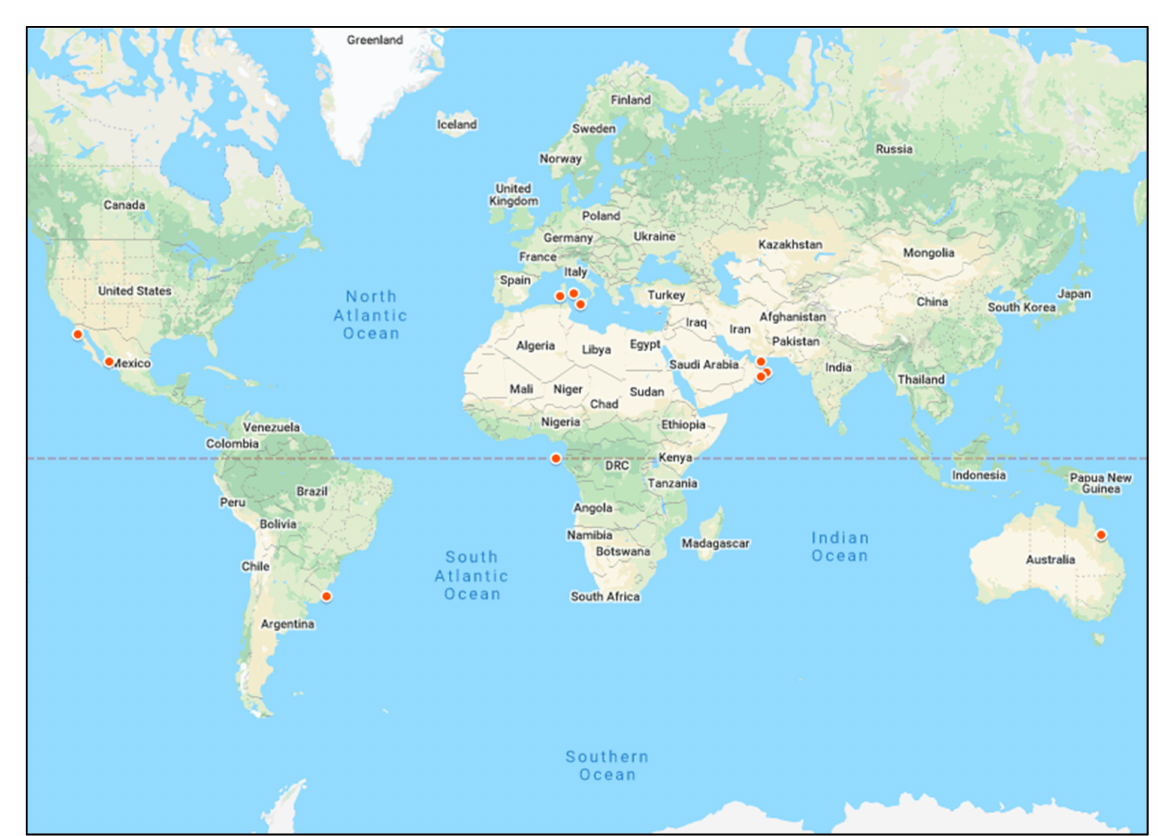
Figure 2. Map of geographical location and clustering of studies on the monitoring of AR in marine environments using sea turtles as an animal sentinel species (red pins). Represented areas are the Mediterranean and Arabian seas, the Pacific Ocean along the east coast of Australia and west coast of Mexico, and the South Atlantic Ocean along the west coast of Africa and the east coast of South America (modified from Google maps under the terms and conditions of the Creative Commons Attribution (CC BY) license). Table 1. Global distribution of geographical sites where different sea turtle species have been examined as sentinel species for AR. The plus sign (+) denotes the isolation of multi-drug-resistant bacterial isolates. Geographical Site & Presumed ARB Source, Food Sources in Marine Turtle Species Biological Sample, MDRB Environments and Dominant Bacterial Isolate